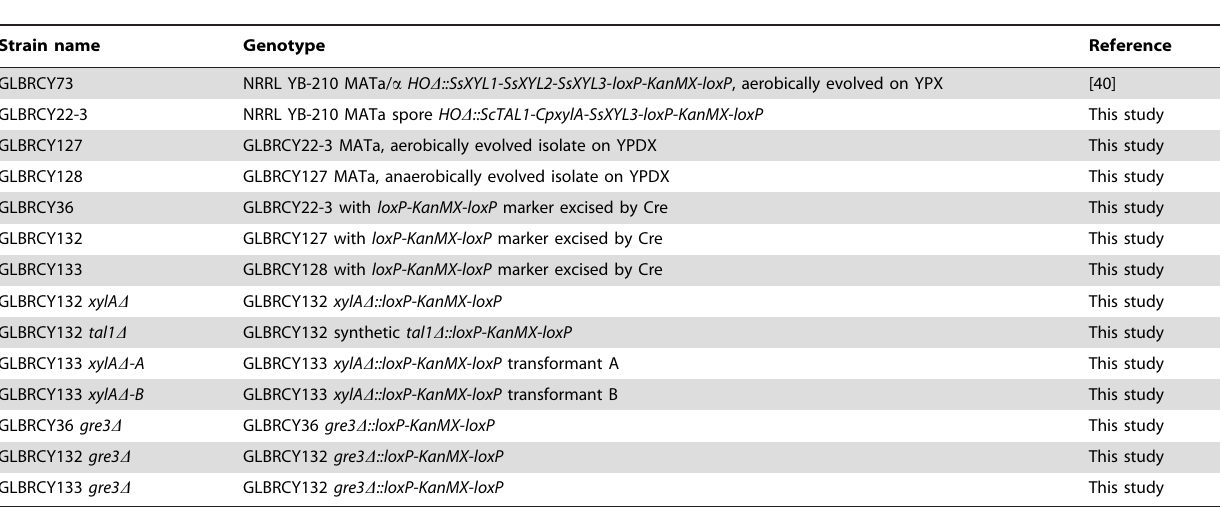
Table 1. Engineered and evolved S. cerevisiae strains used in this